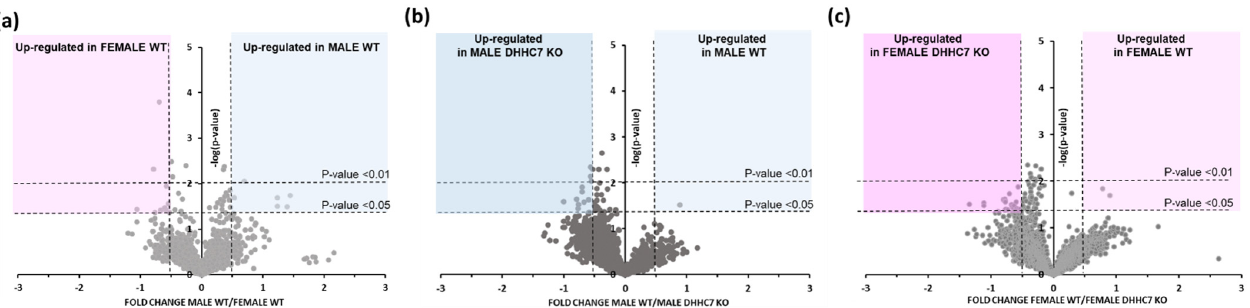
Figure 5. Sex-dependent differences in synaptic protein expression. Volcano plots display differentially regulated synaptic proteins of female and male WT mice ( a ), male WT and male DHHC7 KO ( b ), and female WT and female DHHC7 KO ( c ). Proteins with statistically significant differential expression ( p < 0.05) are highlighted in the top right and left quadrants.